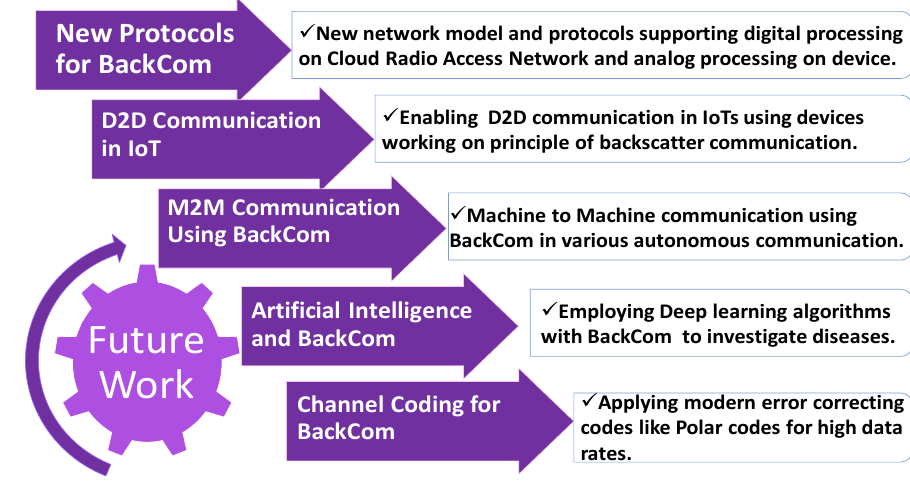
Figure 50. Future